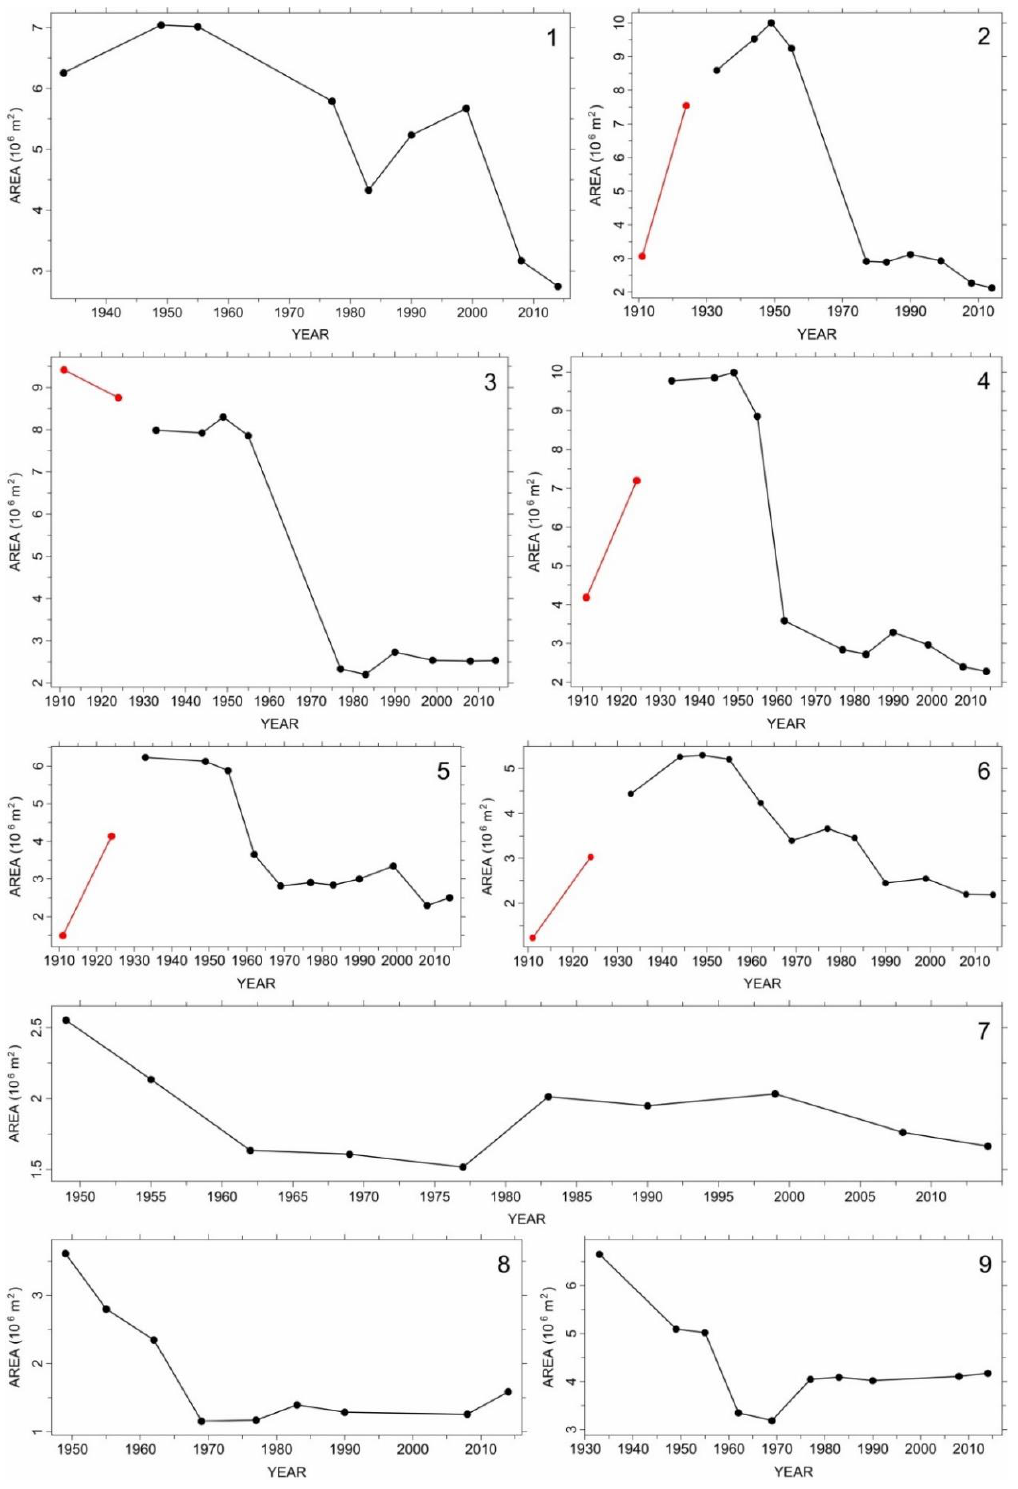
Figure 12. Progression of emerged surfaces for each of the nine sub-areas outside to the levees in PRD coastal area and defined in Figure 1 ( 1 – 9 ): due to the different accuracy, the cartographic data are in red (photogrammetric data in black).